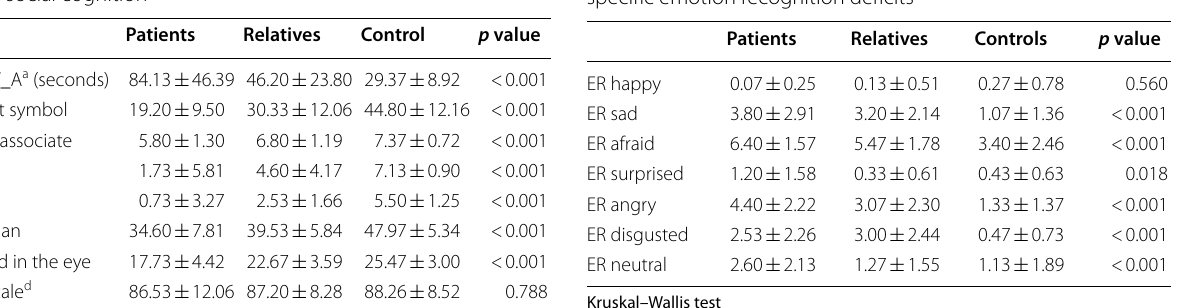
Table 3 Comparison between the three groups as regards